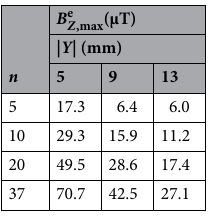
Table 2. Maximum change of the magnetic flux density for all